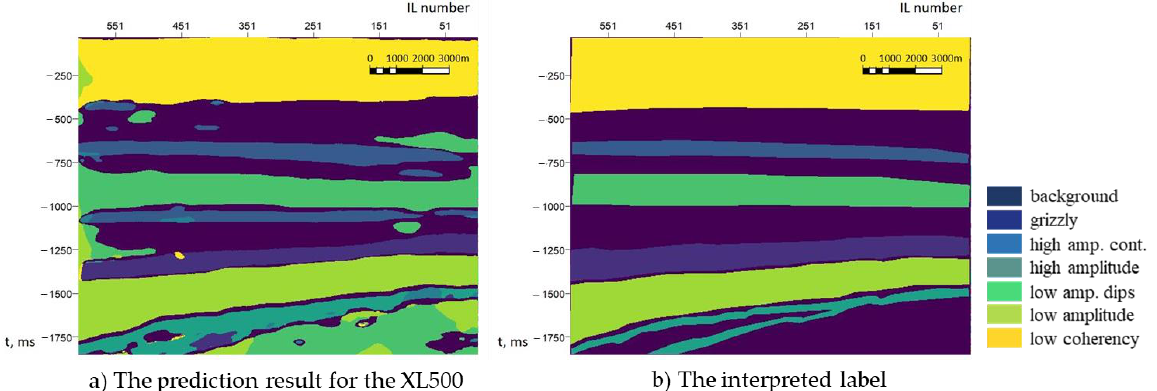
Figure 24. The prediction result for the XL500 of the F3 dataset ( a ) and the interpreted label ( b ).